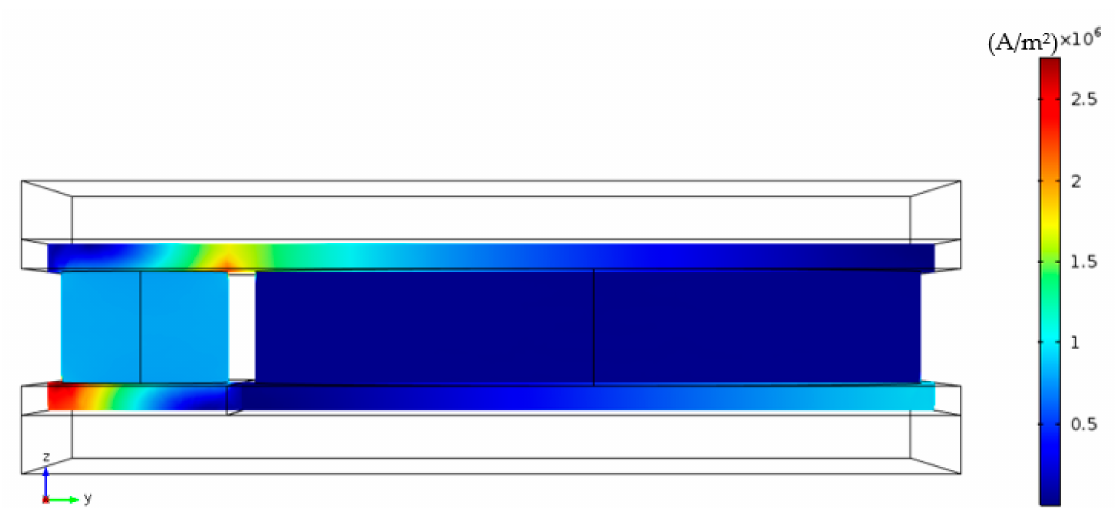
Figure 11. Temperature field [K] at the ( a ) outer surface and ( b ) inner surface of the hot side connector.